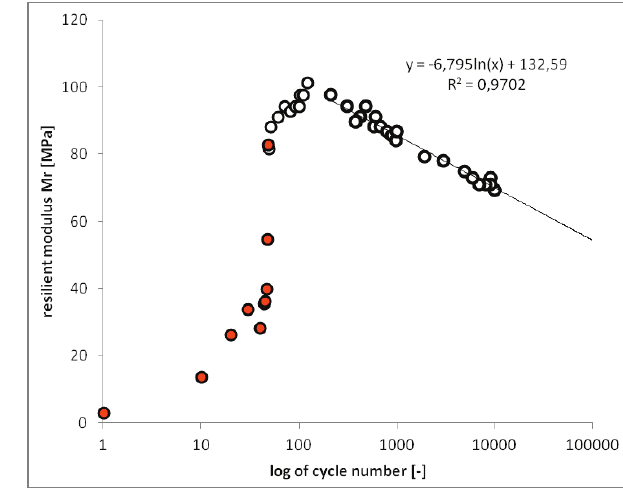
Fig. 4. Plot of the resilient modulus variability during repeated loading (complete points – first phase, empty points – second phase)